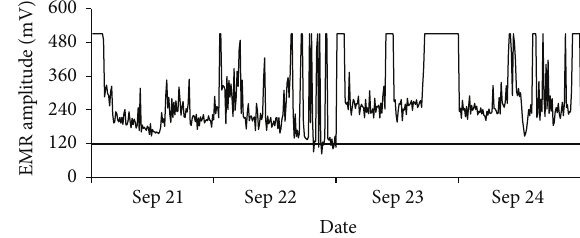
Figure 14: EMR amplitude variation in headentry at the stage of second periodic caving. Note: the caving interval is 17 m, and the pressuring intensity is weaker according to in situ observation of roadway deformation.